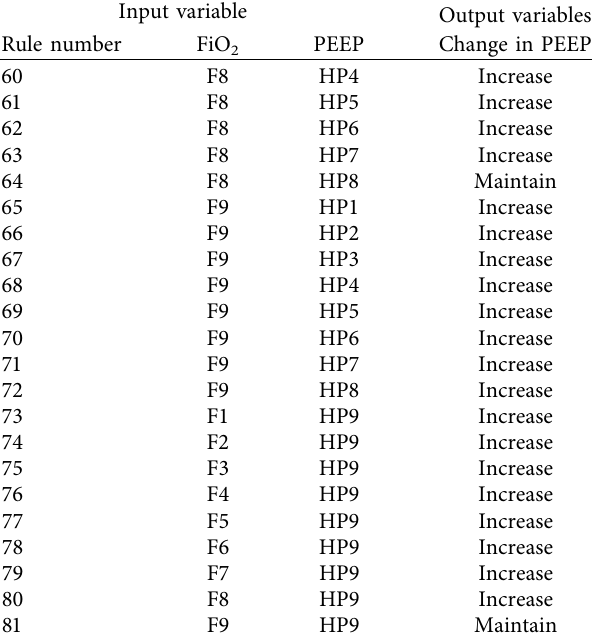
Table 6: FiO 2 and low PEEP fuzzy set